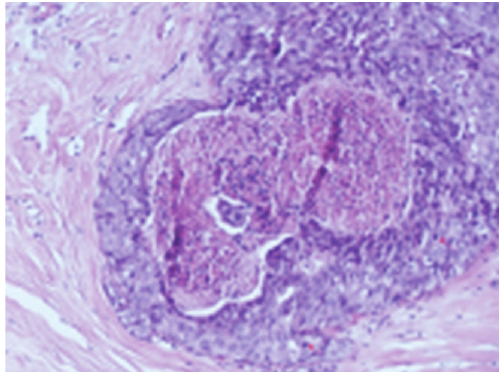
Figure 5: H.E.—high-grade ductal in situ carcinoma (DIN3). Solid intraductal carcinoma with high cytological grade and necrosis ( comedocarcinoma ) and numerous mitosis.